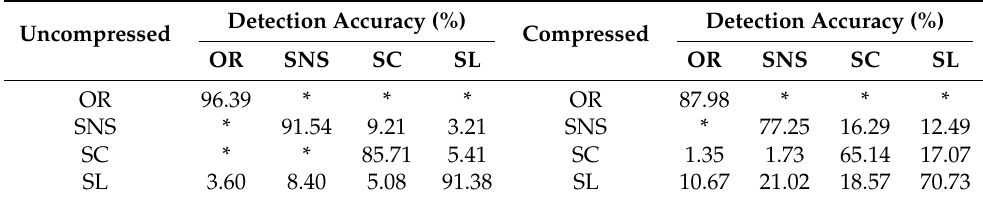
Table 5. CMOMTUI and CMOMTCI without